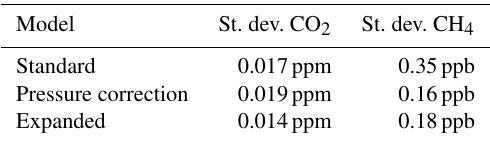
Table 5. Standard deviations of dry air mole fractions based on dif- ferent water correction models from the experiment with Picarro